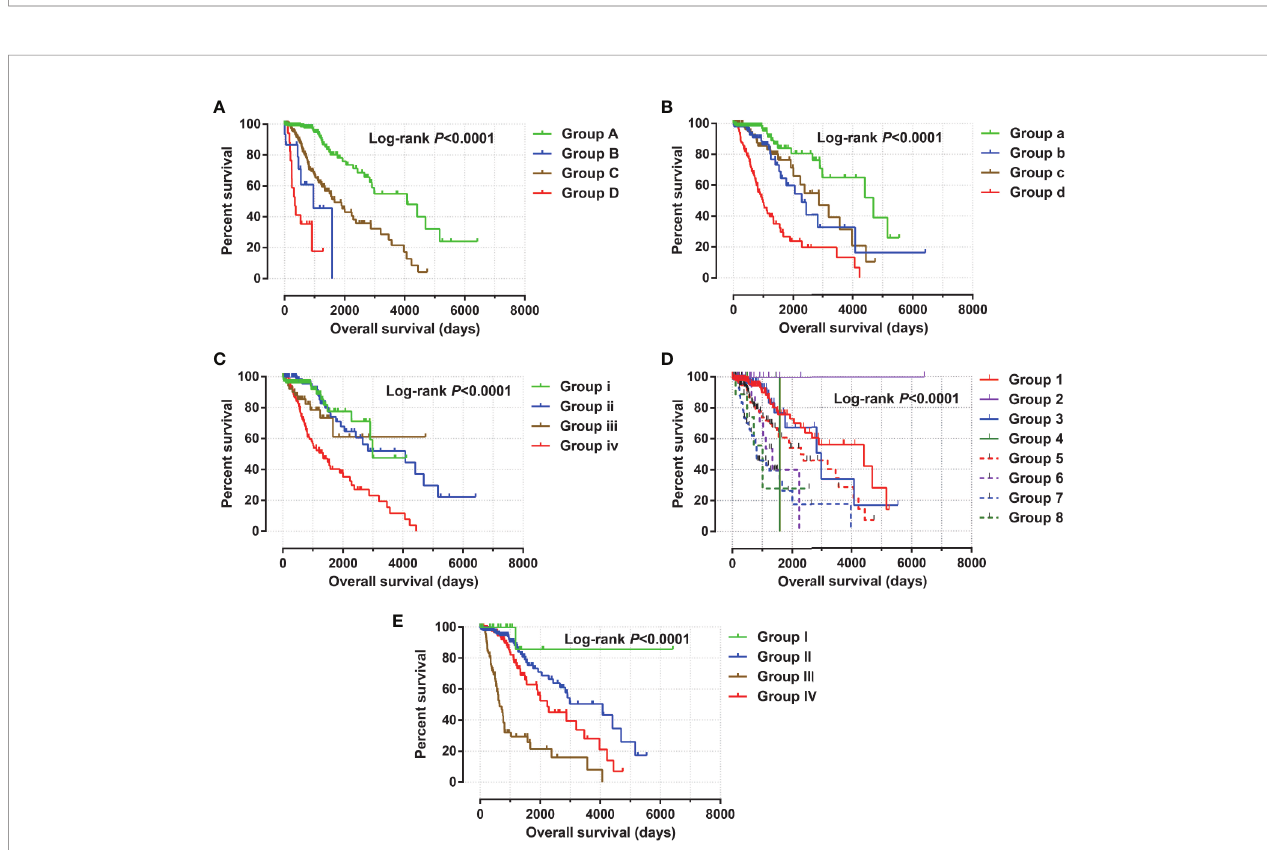
FIGURE 4 | Joint effect survival analysis between risk score and clinical parameters. (A) Combination of risk score and age; (B) Combination of risk score and grade; (C) Combination of risk score and radiation therapy; (D) Combination of risk score and tumor location. (E) Combination of risk score and IDH1